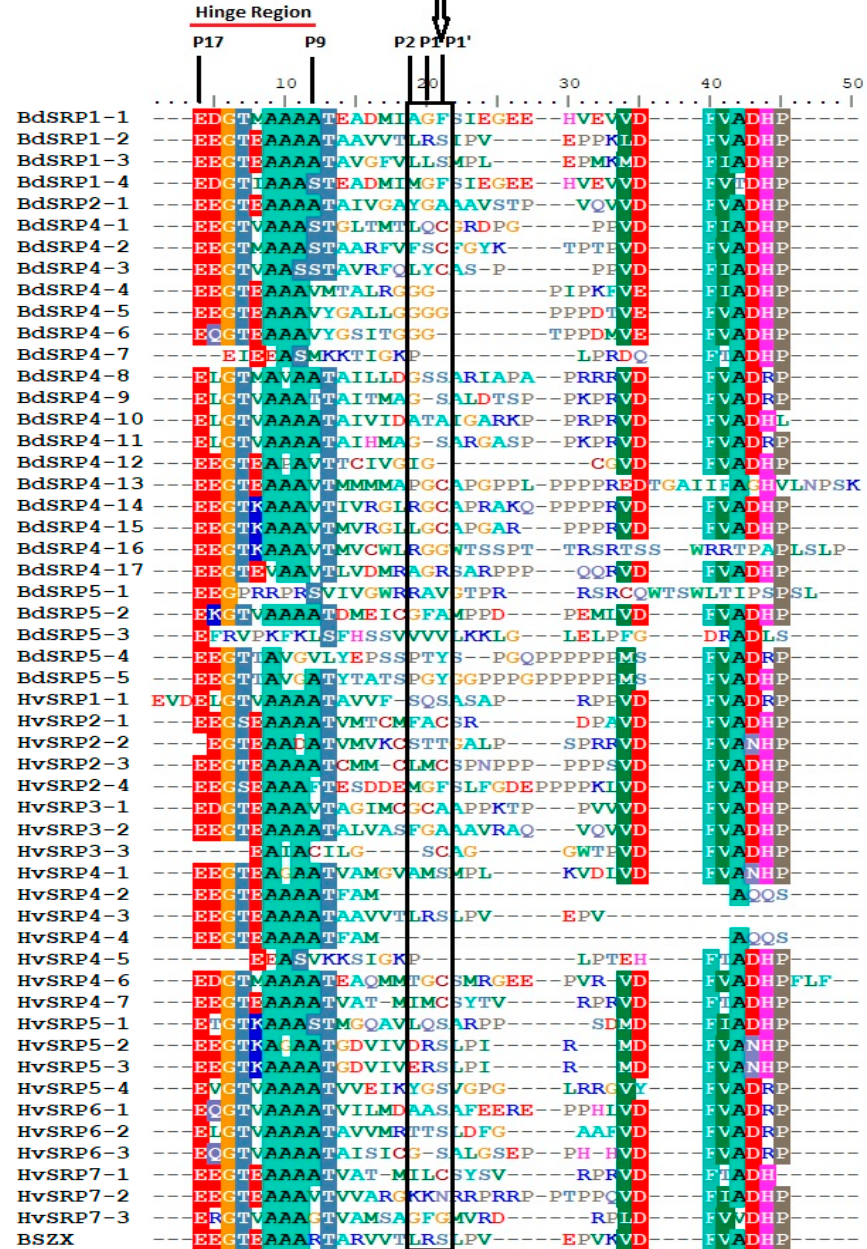
Figure 3. Multiple sequence alignment of the reactive center loop (RCL) of serpin genes in Brachypodium (Bd21) and barley. The reactive site residue P1 is marked by an arrow. The conserved hinge region (P9–P17) is underlined.